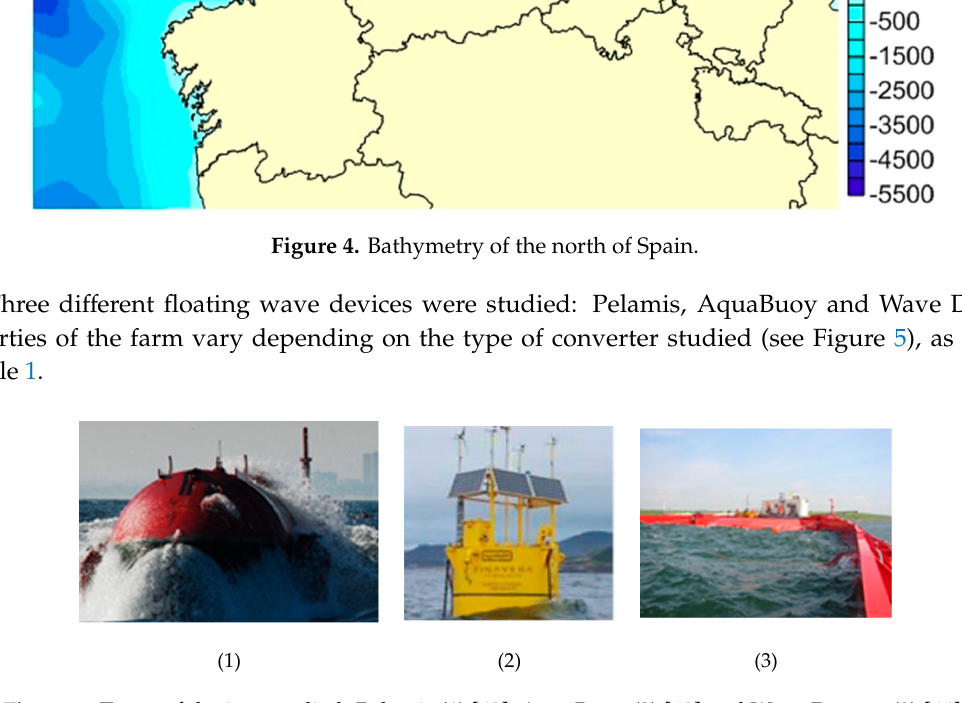
Table 1. Properties of the farms considering different converters.